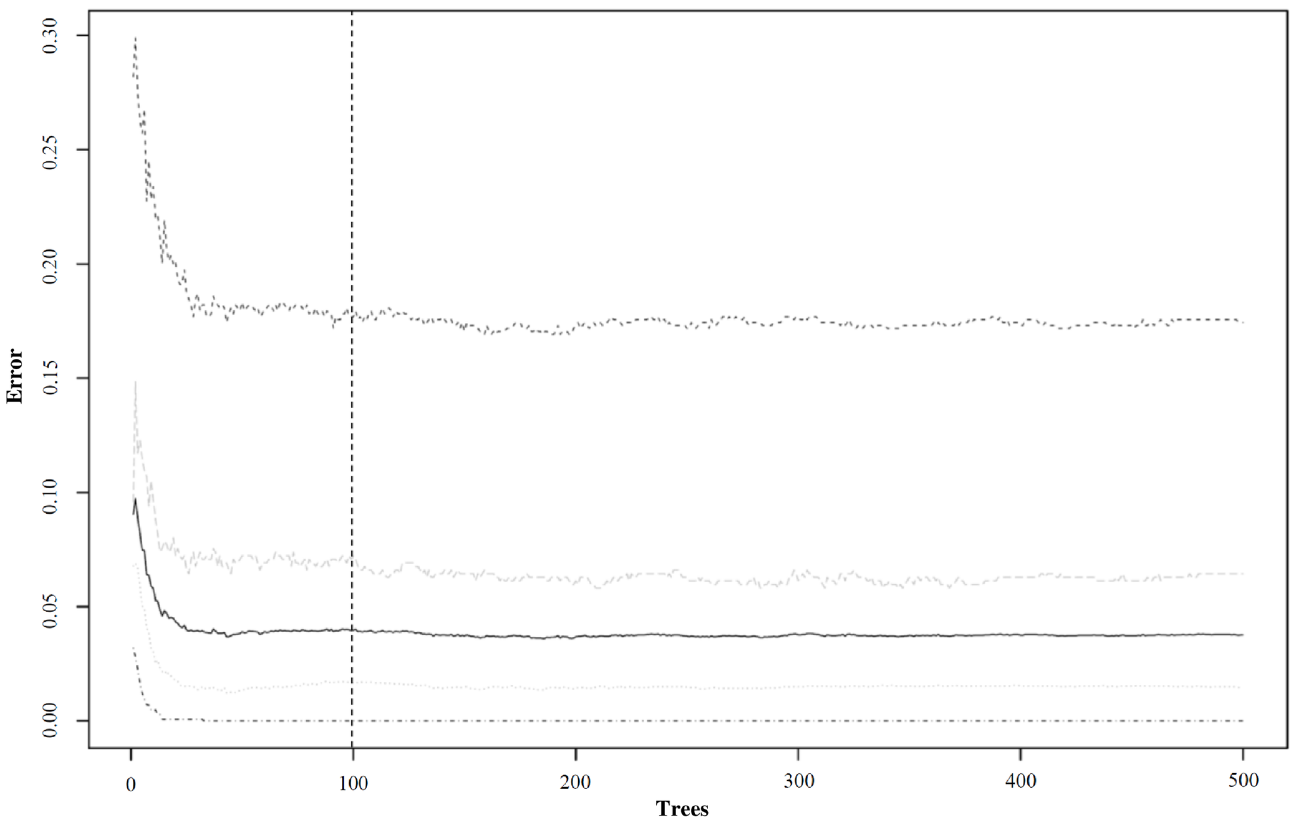
Fig 1. Out-of-bag error analysesfor Random Forest